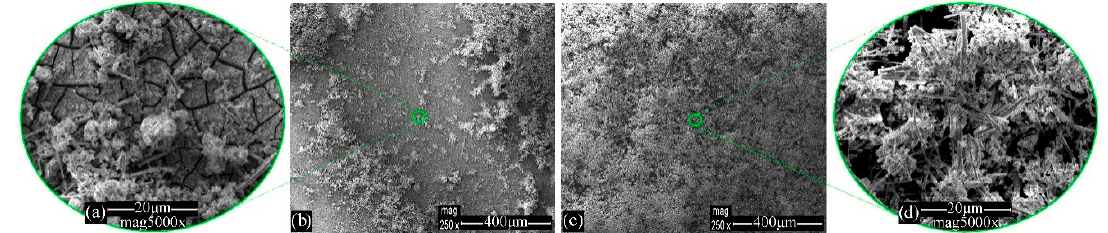
Figure 10. SEM images of mild steel immersed in 3.5 wt % NaCl for 96 h in the presence of Na 2 HPO 4 + MBT. Table 3. Tabulated values of wt % element concentration of mild steel panels prior and after subjection in either WSS, or 3.5 wt % NaCl for 96 h in the presence of inhibitors or not.